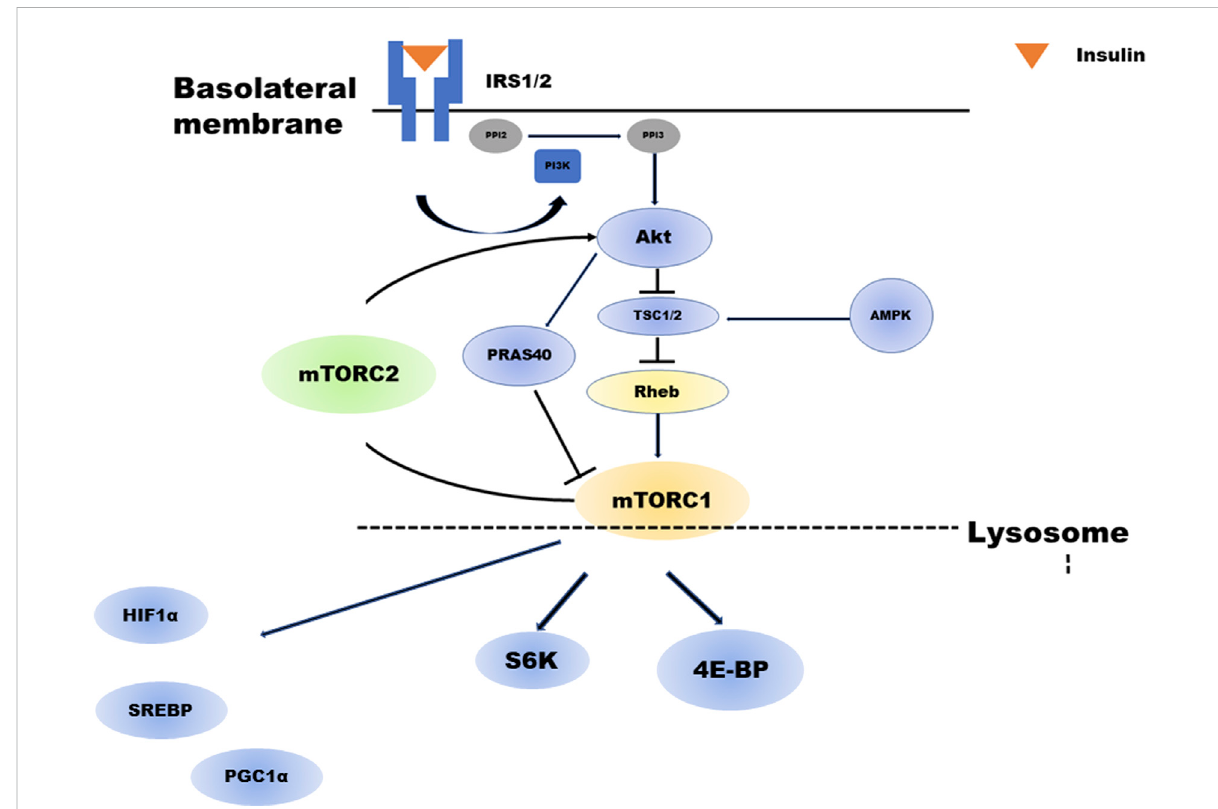
FIGURE 1 Overview of the mTOR cascade. Insulin activates both mTORC1 and mTORC2. Akt regulates mTORC1. TSC2 phosphorylated by insulin- activated Akt will have its activity suppressed. As a result, the activity of GTP-bound Rheb increases, and mTORC1 is activated. In addition, Akt phosphorylates PRAS40, which in turn activates mTORC1. mTORC1 regulates several negative feedback loops that control IRS1/2 and mTORC2 signaling: direct inhibition of IRS1/2 and indirect inhibition of mTORC2 via S6K1. abrAbbreviationsmTORC; mechanistic target of rapamycin complex, Akt; Protein kinase B, TSC; tuberous sclerosis complex, PRAS40; proline-rich Akt substrate of 40 kDa, IRS; insulin receptor substrate, PIP2; Phosphatidylinositol 4,5-bisphosphate, PIP3; Phosphatidylinositol